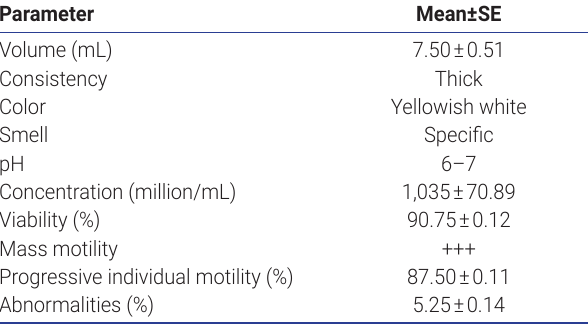
Table 1. The characteristics of fresh Simmental bull semen (four bulls, three ejaculates